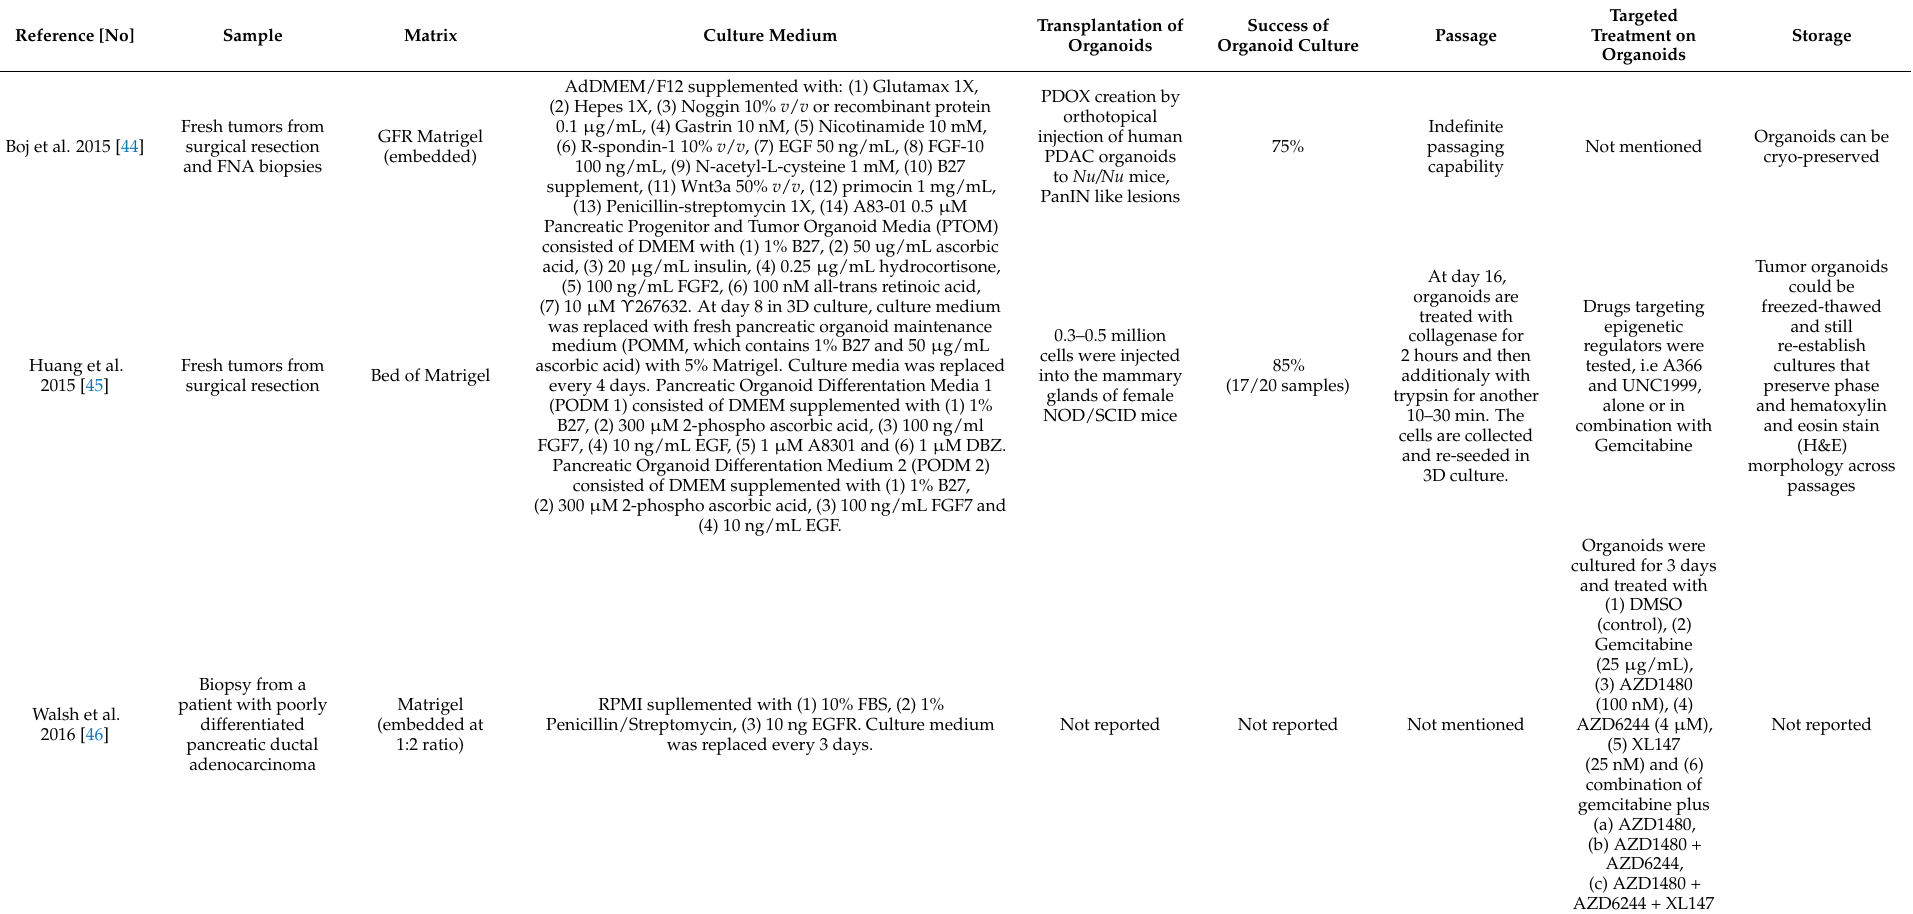
Table 1. Human PDAC organoid culture